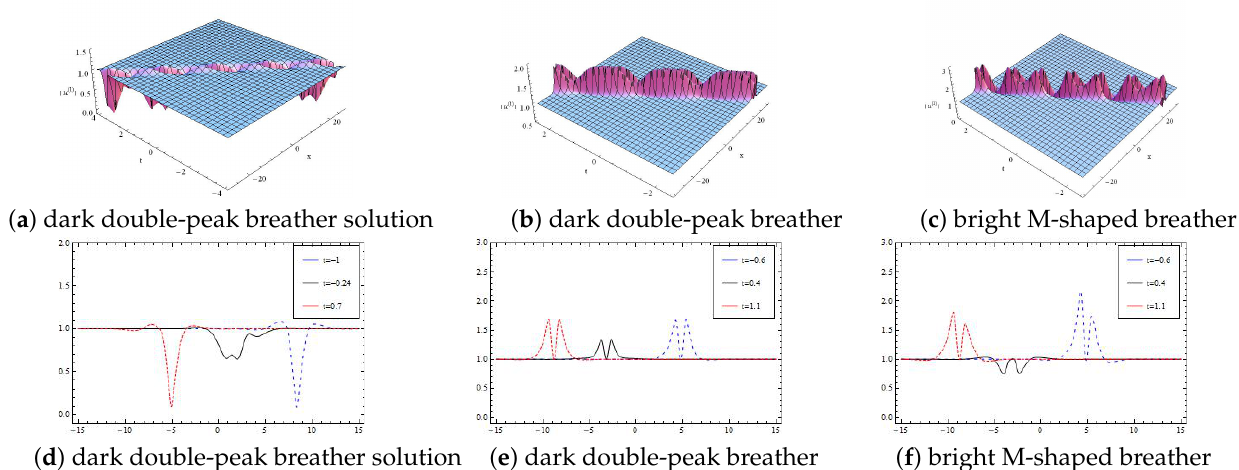
Figure 7. Breather solutions for the defocusing nonlocal gSS Equation (5) with (cid:101) = 1, a = 1, b = 1 d 12 = 0, α 1 = 1: ( a , d ) bright-bright breather solution with d 13 = 1; ( b , e ) dark double-peak breather solution with d 13 = 3; ( c , f ) bright M-shaped breather solution with d 13 = 3i.